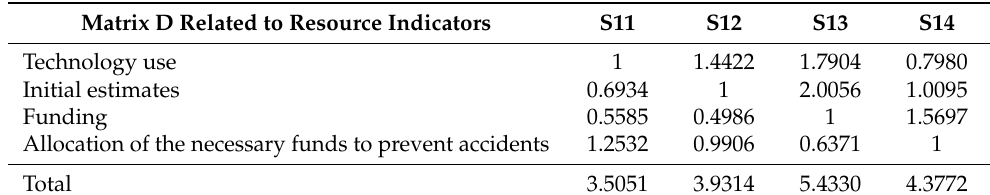
Table 11. Pairwise comparison matrix related to resource indicators.